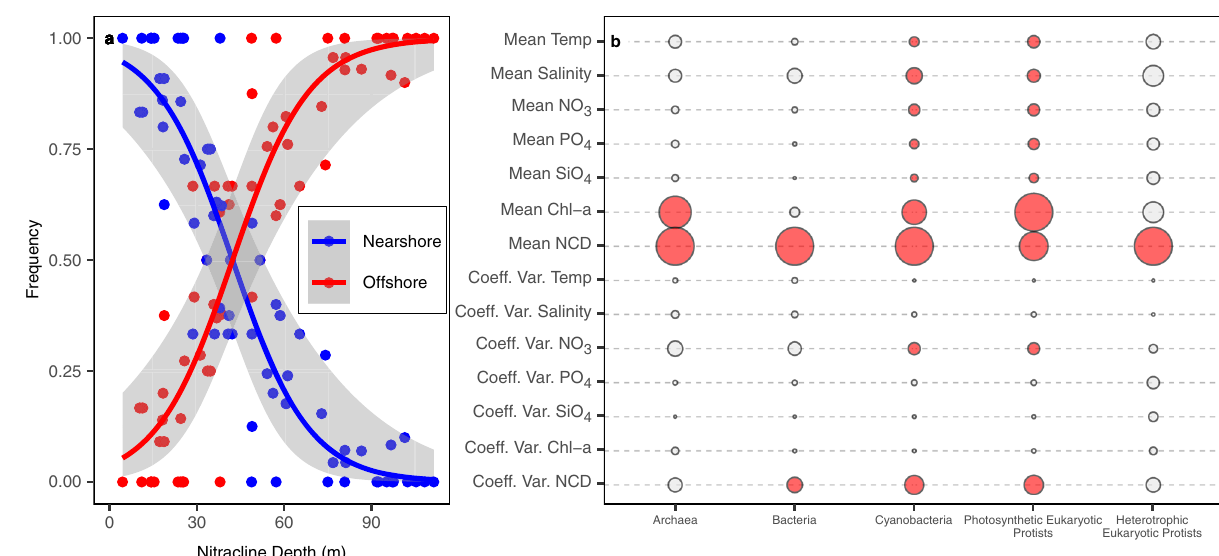
Fig. 3 Environmental drivers of community structure. a Example relationship between mean nitracline depth (m) and the frequency of observed community clusters ( “ Nearshore ” in blue or “ Offshore ” in red) per station for cyanobacteria. Lines represent a generalized linear model with a binomial fi t. Shading represents a 95% con fi dence interval around the model fi t ( b ), relative importance of all explanatory variables (mean and coef fi cient of variation) used to predict the frequency of SOM clusters at a given station. As in the example ( a ), relationships were assessed via a generalized linear model with a binomial fi t. Larger circles represent lower AIC values within a column; in other words, variables with larger circles are likely to be more important drivers than variables with smaller circles. Relationships that are not signi fi cant ( p > 0.05) are colored in gray. Circles and their associated AIC values should not be compared across columns, only within columns, as AIC values are speci fi c to each response variable. Relationships were analyzed between the frequency of observed community clusters and the mean and coef fi cient of variation (Coeff. Var.) of environmental variables. Environmental variables included: temperature (Temp), salinity, NO 3 , PO 4 , SiO 4 , chlorophyll a (Chl-a), and nitracline depth